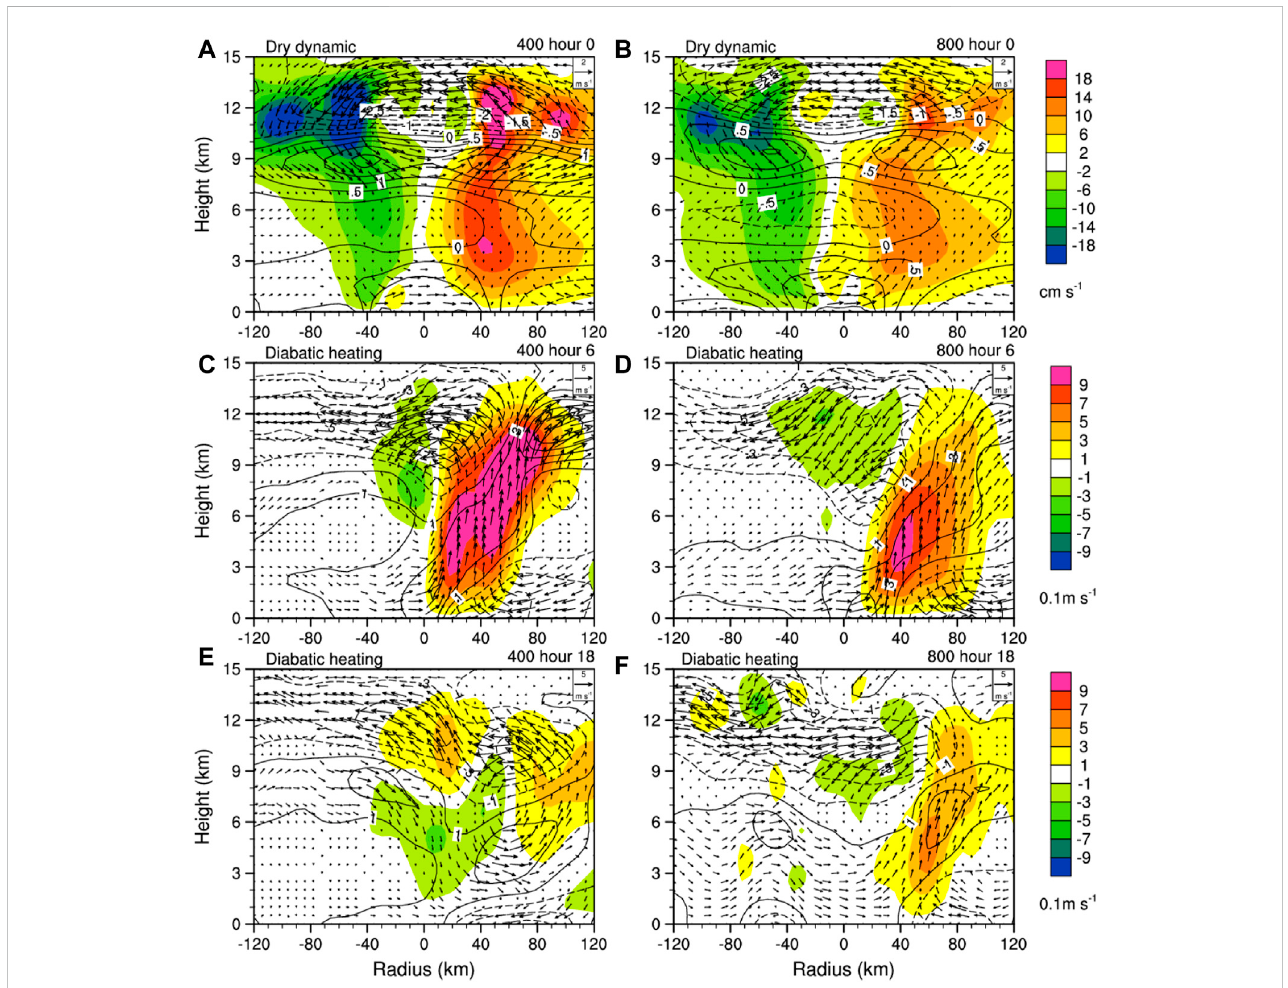
FIGURE 12 Shear induced second circulation. Shading indicates the induced vertical velocities (m s − 1 ), the vectors denote the in plane horizontal and vertical winds, and the contours indicate the magnitudes of divergence wind. The top panels are the dry dynamic-induced vertical velocity at hour 0 in EXP400 (A) and EXP800 (B). (C – F) Vertical section of the diabatic heating induced divergence wind and vertical wind (vector) along the tilting vector shown in Figure